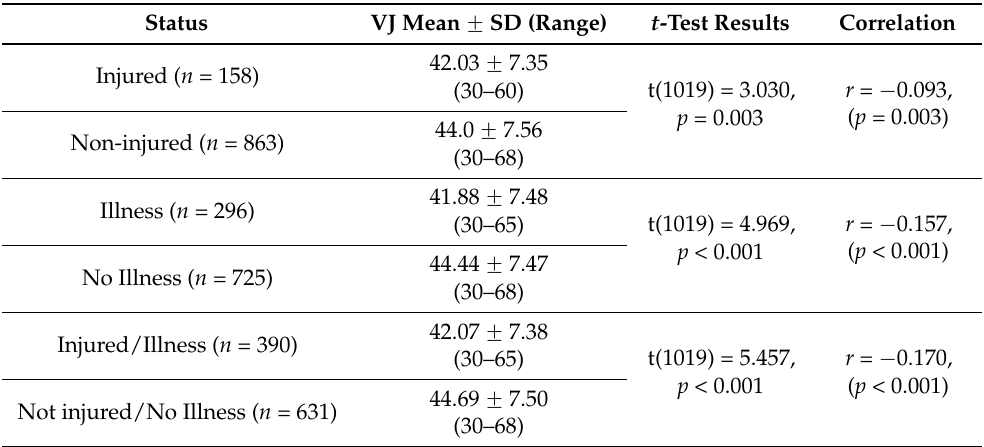
Table 4. Descriptive analysis, demographics and statistical results in each